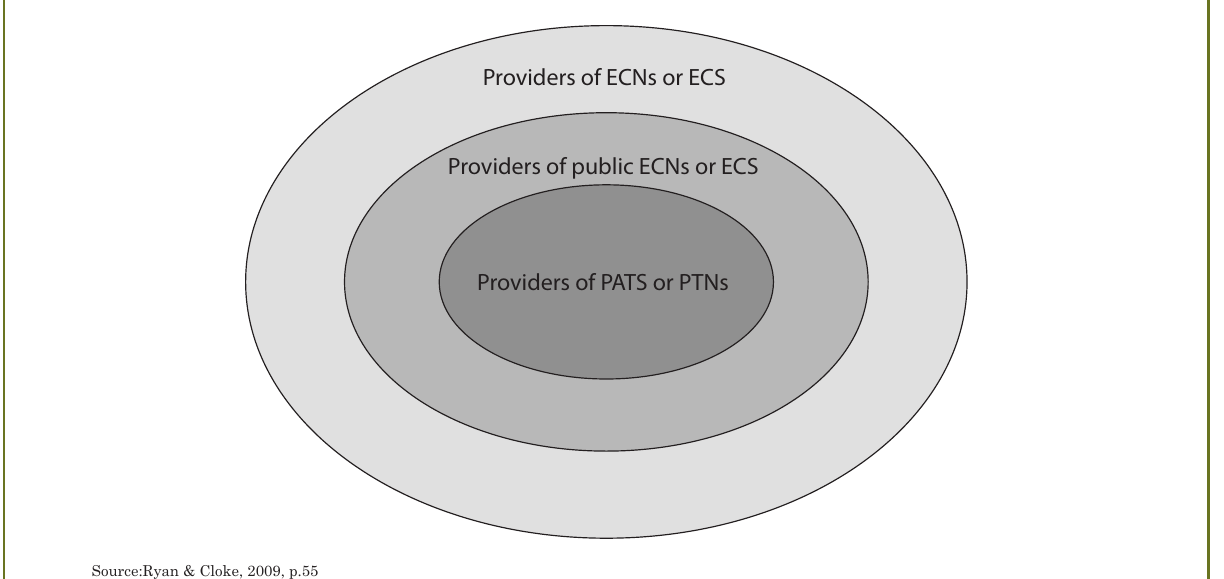
Source:Ryan & Cloke, 2009, p.55